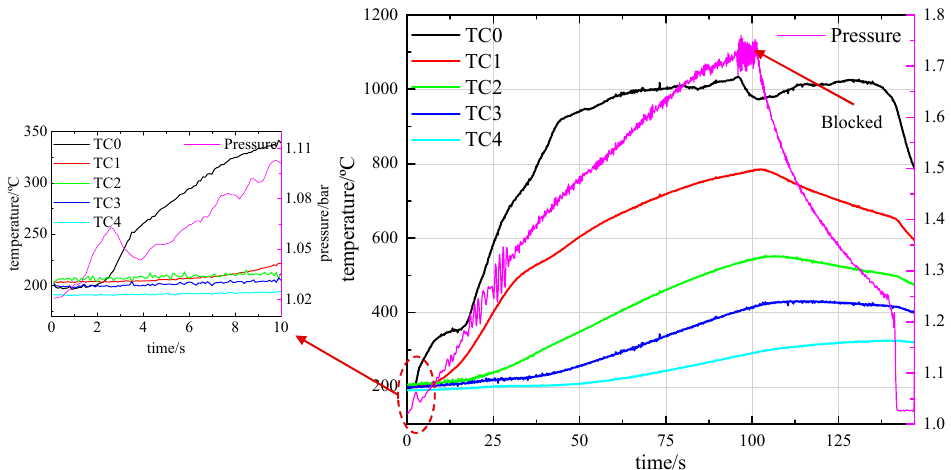
Figure 7. Temperature and pressure curve of a model thruster with the convergent nozzle at a 2 mL/min flow rate.